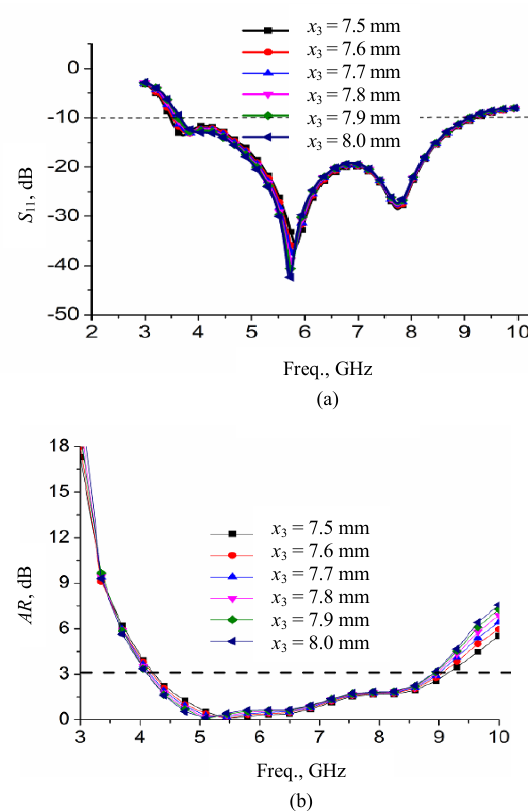
Fig. 10. Effect of ‘ x 3 ’ on impedance bandwidth and axial ratio.